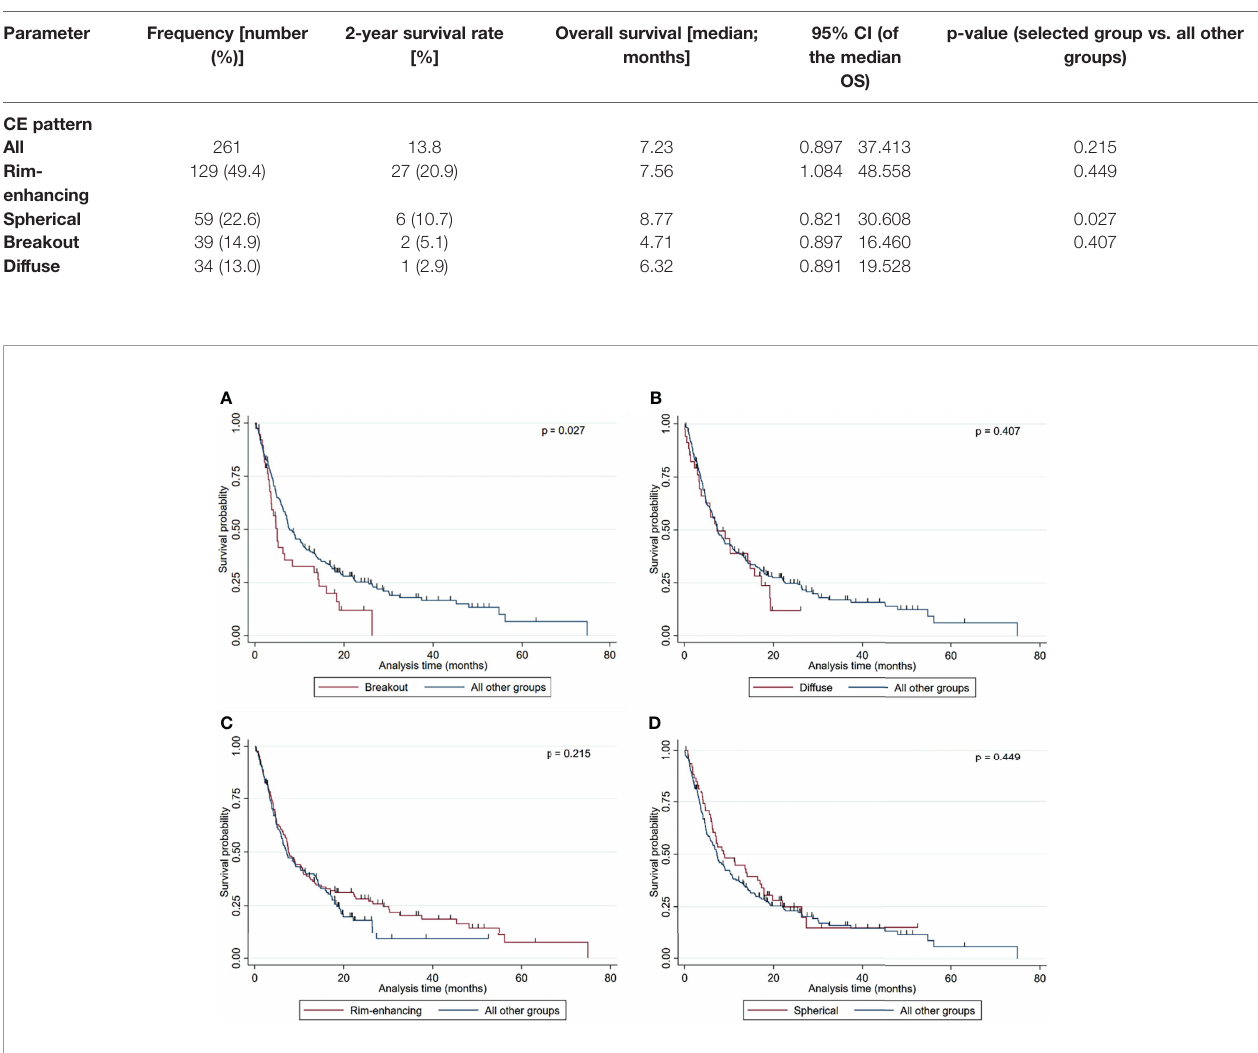
FIGURE 2 | Kaplan – Meier curves showing the overall survival probability strati fi ed by (A) breakout vs. all other MRI subgroups, (B) diffuse vs. all other MRI subgroups, (C) rim-enhancing vs. all other MRI subgroups, and (D) spherical vs. all other MRI subgroups. Statistical analysis was performed by calculating log-rank analyses.